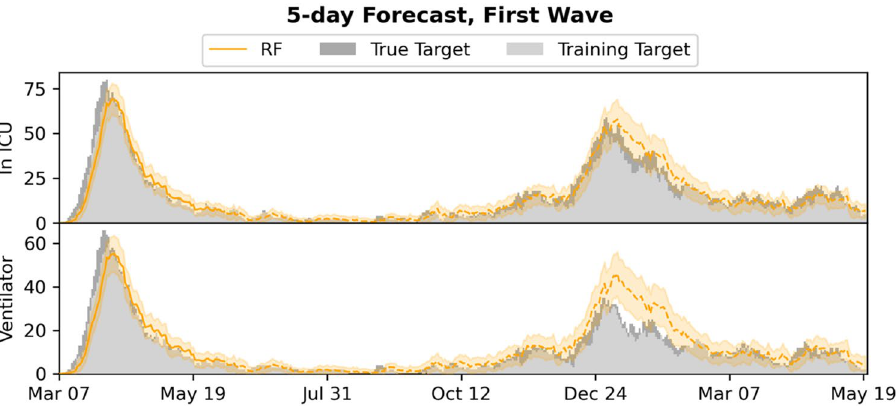
Figure 6. 5-day forecasts of admission to ICU and use of mechanical ventilation, compared to the training and true targets in the first wave setting. Predictions and targets for both the first wave (training data) and the subsequent waves (test data, dashed) are shown, as well as the 95% confidence